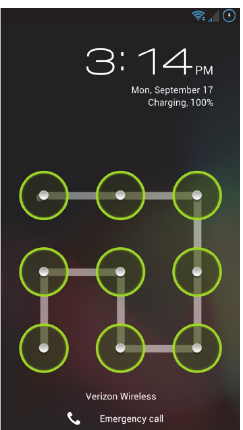
Figure 2: The default Android grid lock, showing a lock pattern for a 3 × 3